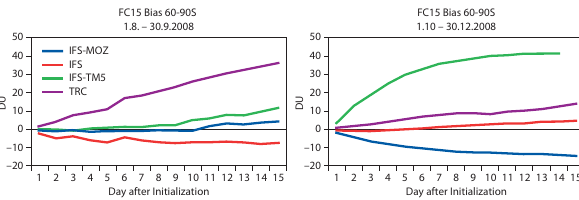
Fig. 9. Bias of the ozone total columns over 60-90 ◦ S from the FC15 runs with IFS-MOZART (blue), IFS (red), IFS-TM5 (green) and a tracer without chemistry (TRC, purple) for the period of the ozone hole development (left: 1 August–30 September, average of four FC15 runs) and its closure (right: 1 October–31 December, average of six FC 15 runs). The FC15 runs were initialized with ozone analyses at the forecast